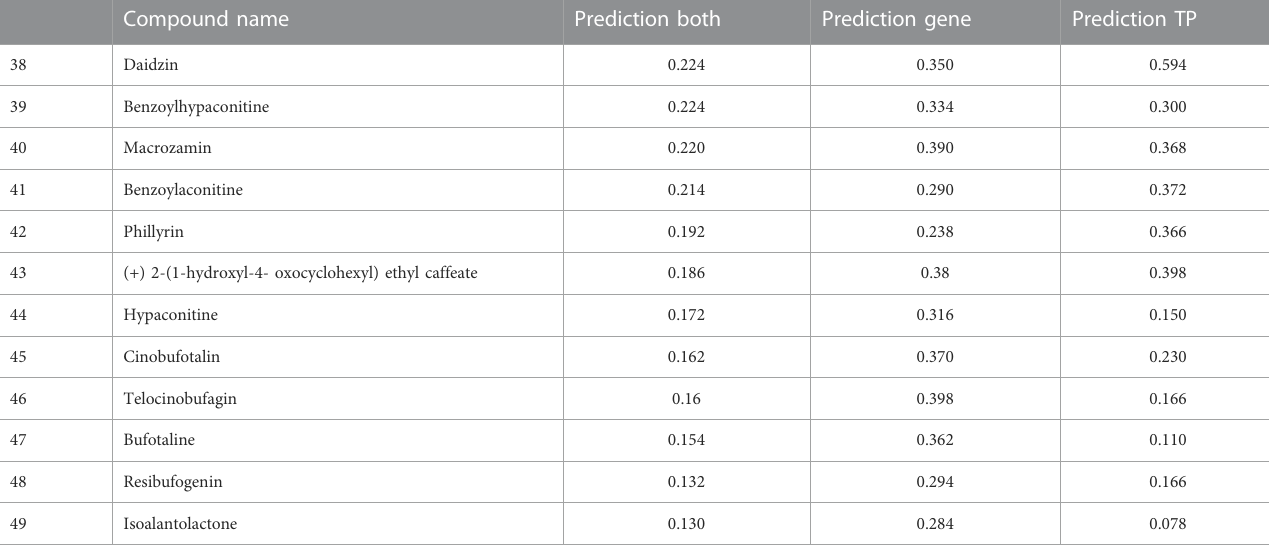
TABLE 2 ( Continued ) Prediction results of 49 individual “ unknown metabolites ” ranking their probability of being pro-angiogenic or anti-angiogenic by Machine Learning developed in the current study. Prediction Gene means predicted by gene expression; Prediction TP means predicted by PIDGIN targets; Prediction Both means predicted by both gene expression and PIDGIN targets. The probability of individual TCM metabolites being pro-angiogenic or anti-angiogenic is ranked by Prediction Both, with values close to 1 for promoters, and values close to 0 for inhibitors.